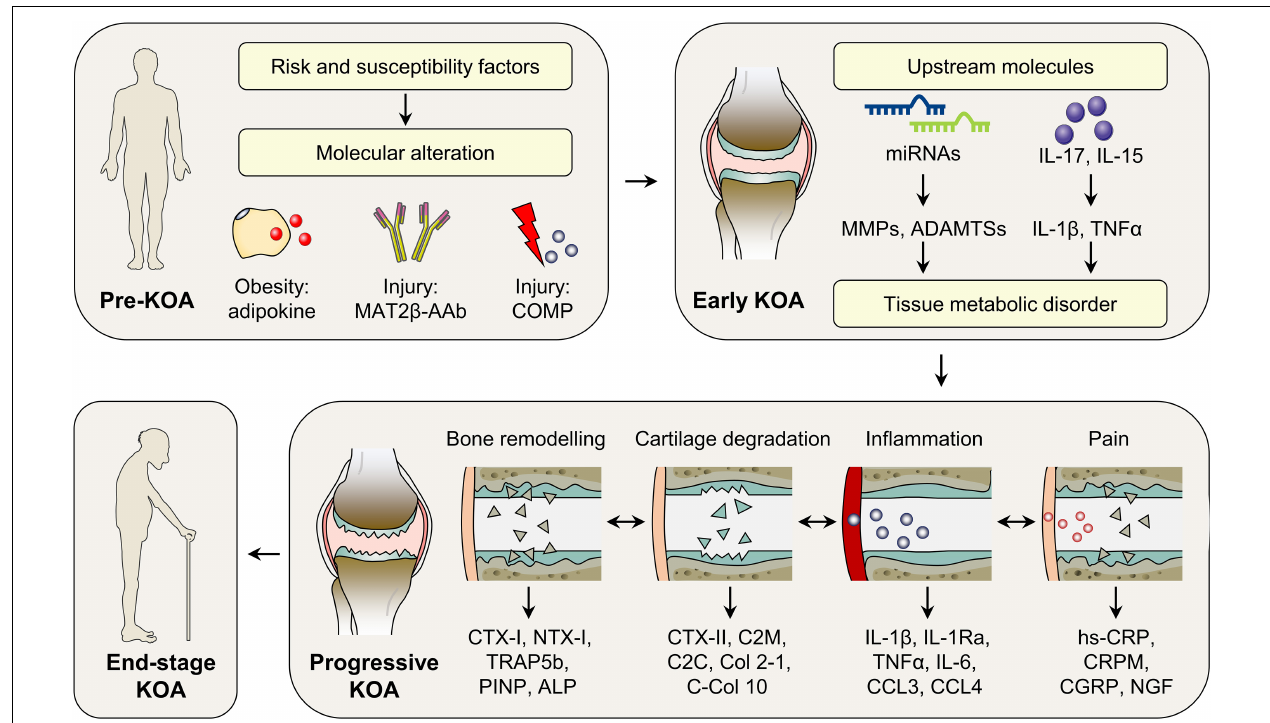
FIGURE 3 | Molecular classification of KOA. According to the temporal alteration of representative molecules during disease initiation and progression, KOA could be classified into pre-KOA, early KOA, progressive KOA, and end-stage KOA. In pre-KOA, risk factors-related molecules, such as adipokines, COMP, and MAT2 β -AAb, can be detected in body fluids, which may provide evidence for KOA prediction. In early KOA, molecules can reflect the ongoing pathogenesis, when symptoms and imaging information are ambiguous. Based on the major pathophysiology in patient clusters, progressive KOA is further classified into four subtypes, i.e., cartilage degradation-driven subtype, bone remodeling driven subtype, inflammation-driven subtype, and pain-driven subtype, suggesting different treatment options in future clinical setting. ADAMTSs, a disintegrin and metalloproteinase with thrombospondin motifs; ALP, alkaline phosphatase; CCL3, CC-chemokine ligand 3; CCL4, CC-chemokine ligand 4; C-Col 10, C-terminus of collagen X; CGRP, calcitonin gene-related peptide; COMP, cartilage oligomeric matrix protein; CRPM, the fragment of CRP; CTX-I, C-telopeptide of Col-I; CTX-II, C-telopeptide fragments of Col-II; C2C, the cleavage neoepitope of collagen II; C2M,